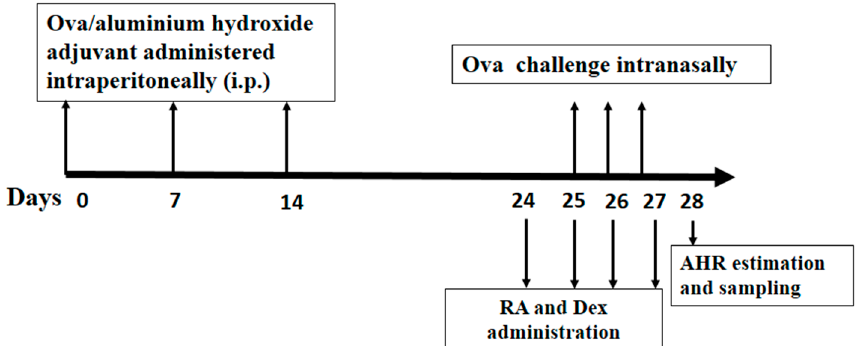
Figure 9. Experimental protocol for the development of allergic asthma and pretreatment with RA or Dex using a murine model. Mice were divided into six groups ( n = 12 in each group) and sensitized using a 100 μ g/mL Ova solution on days 0, 7, and 14. Subsequently, the mice were challenged with a 2 mg/mL Ova solution on days 25–27. Then, they were injected intraperitoneally with RA (5, 10 or 20 mg/kg) or Dex (2 mg/kg) on days 24–27 at 1 h prior to Ova challenge on days 25–27. Control mice were sensitized and challenged with equivalent volumes of PBS without RA or Dex.